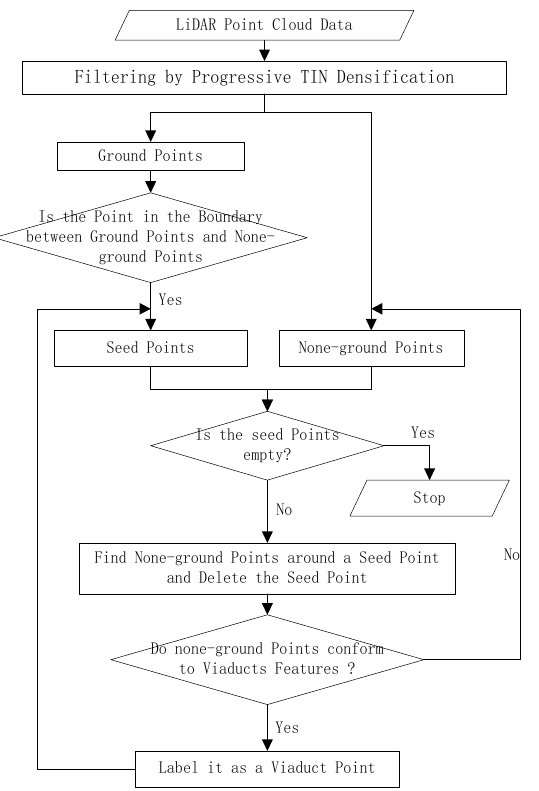
Figure 3. Algorithm Flow Chart of Extracting Viaducts Points 2.2.1